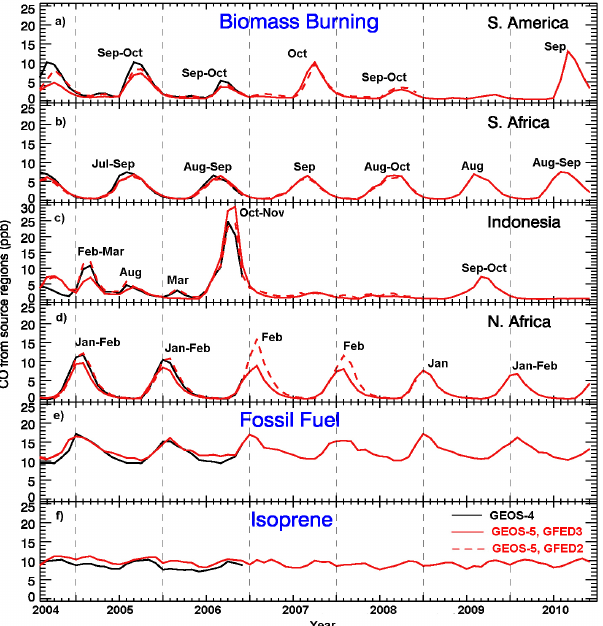
Fig. 9. Temporal variation of modeled monthly mean CO mixing ratios zonally-averaged over the tropics (10 ◦ S to 10 ◦ N) at 215hPa from surface biomass burning in (a) South America (0–20 ◦ S, 72.5– 37.5 ◦ W), (b) southern Africa (16–4 ◦ S, 12.5–37.5 ◦ E), (c) north- ern Africa (4 ◦ S–8 ◦ N, 7.5–22.5 ◦ E), and (d) Indonesia (12 ◦ S–8 ◦ N, 87.5–122.5 ◦ E) at 215hPa, showing the boundary condition for CO entering the stratosphere. Panel (e) shows the CO variation from fossil fuels/industry. The bottom panel (f) shows the CO variation from oxidation of isoprene. Red solid lines show model results from GEOS-5 with GFED3 emissions and red dashed lines show re- sults with GFED2 emissions. Black lines show model results from